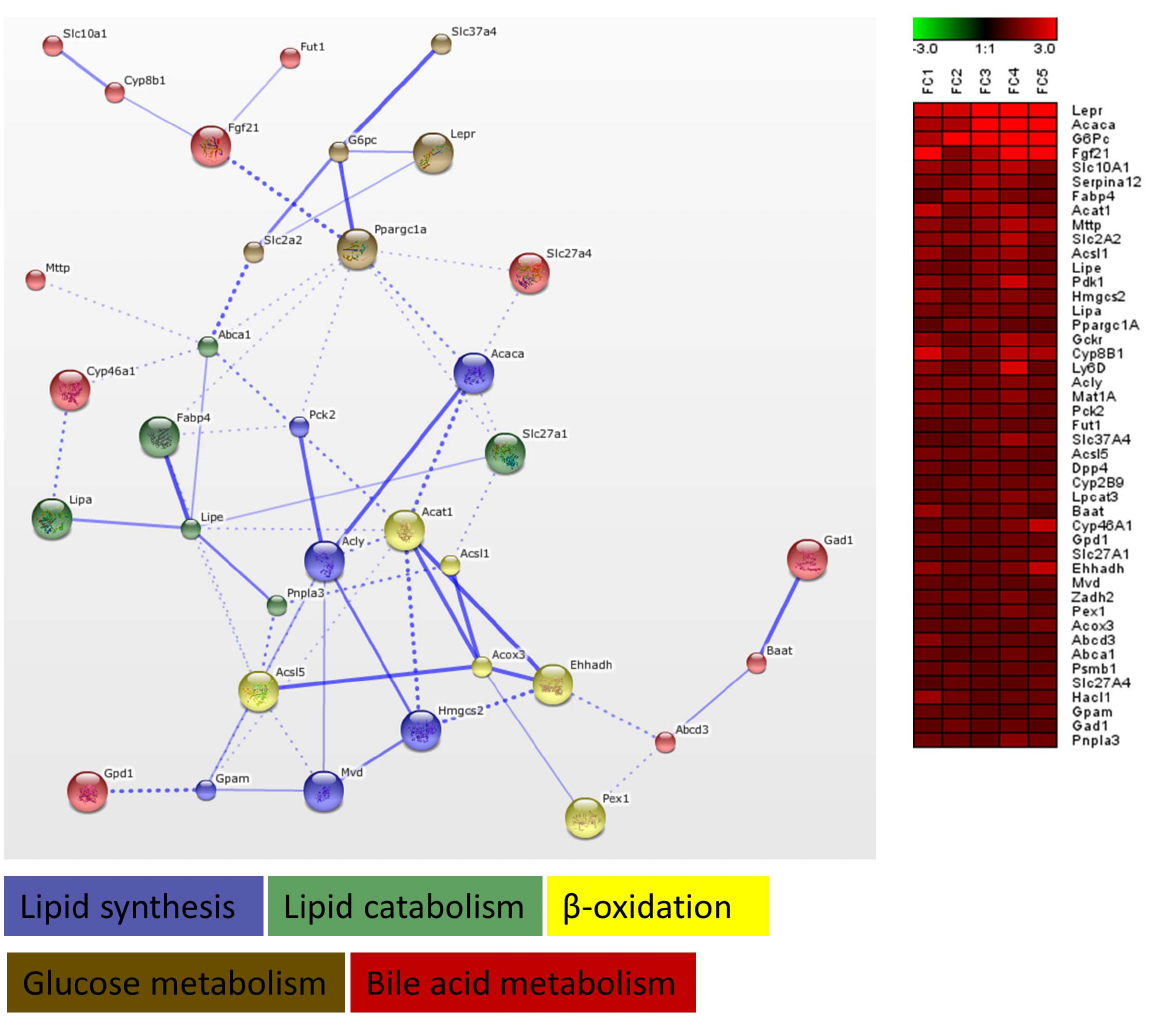
Figure 4. Functional clustering of genes involved in energy metabolism (valproic acid). Genes related to energy metabolism identified by GSEA as being significantly altered upon valproic acid (VA) treatment were subjected to functional clustering in STRING. Functional clusters such as lipid synthesis, lipid catabolism, b -oxidation, glucose metabolism, and bile acid metabolism have been identified. Information about fold change (FC=treatment vs. control) for the analysed genes in individual mice is presented as a heat map. For further explanation of the networks see Fig.